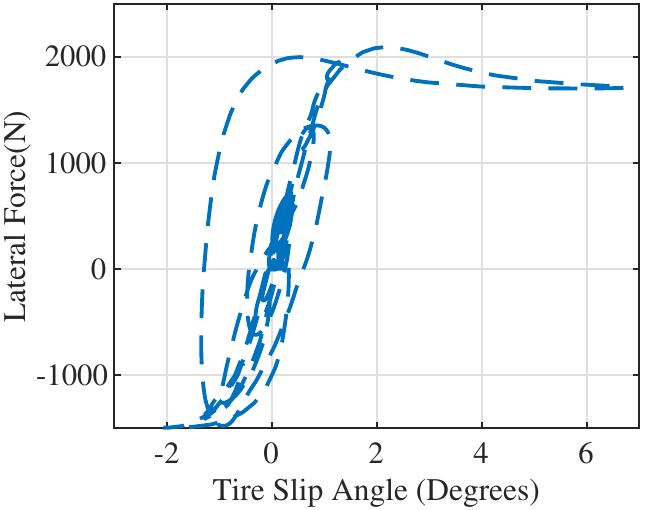
Figure 11. The behavior of lateral force with respect to the tire slip angle for v x = 100 km/h in the presence of disturbance and a variety of road conditions, µ ∈ [ 0.4–0.85 ]